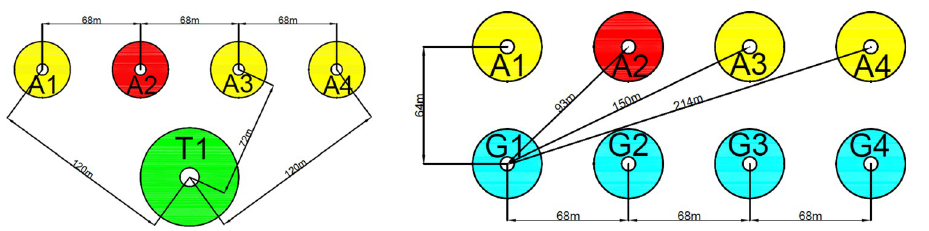
Fig 8. Layout of the analysis nodes in case study [58]. (a) Layout of a large silo (T1) and gasifier (A1, A2, A3, A4). (b) Layout of pulverized coal giving tanks (G1, G2, G3, G4) and gasifiers (A1, A2, A3, A4).